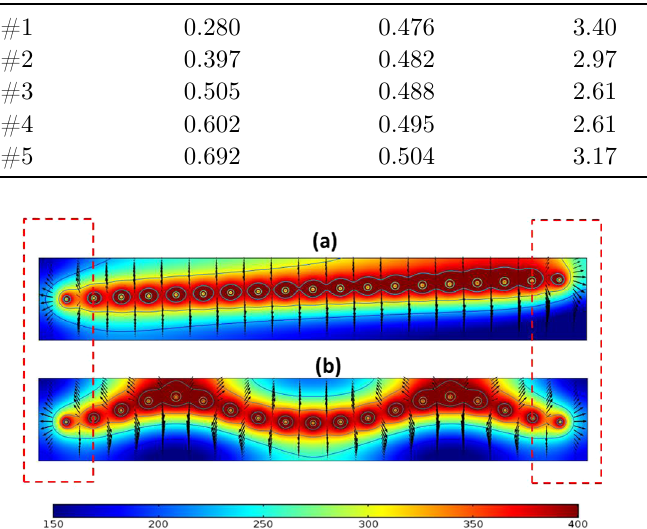
Fig. 10. Boundary effect illustrated by the simulated tempera- ture fi eld within the press plate for the tested pro fi les (a) pro fi le #1 and (b) pro fi le #2. Temperature in degree Celsius.